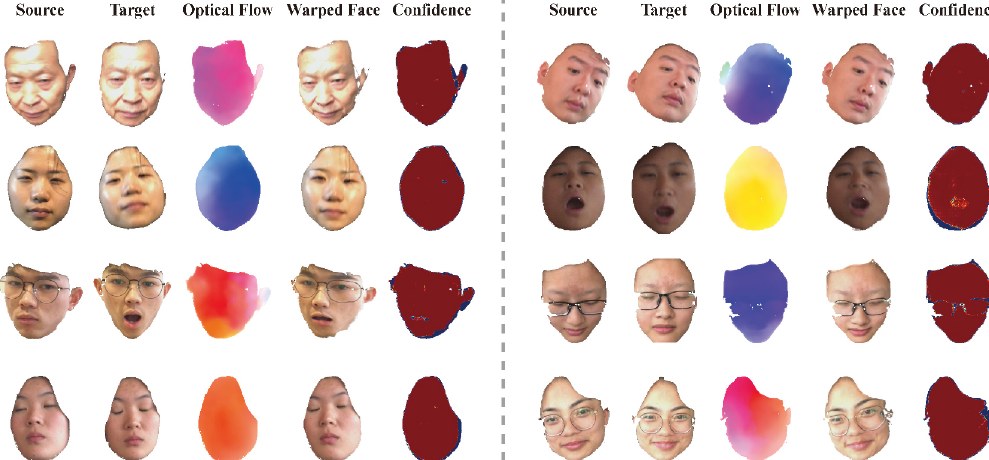
Fig. 7 Eight further qualitative results on our test dataset, arranged in two columns of 4 frame pairs. Each frame pair shows: source frame, target frame, predicted source-to-target optical flow, backward target-to-source warped face utilizing the optical flow, and estimated source-to-target confidence weight (red indicates higher confidence, blue lower). The backward warped faces are consistent with the source